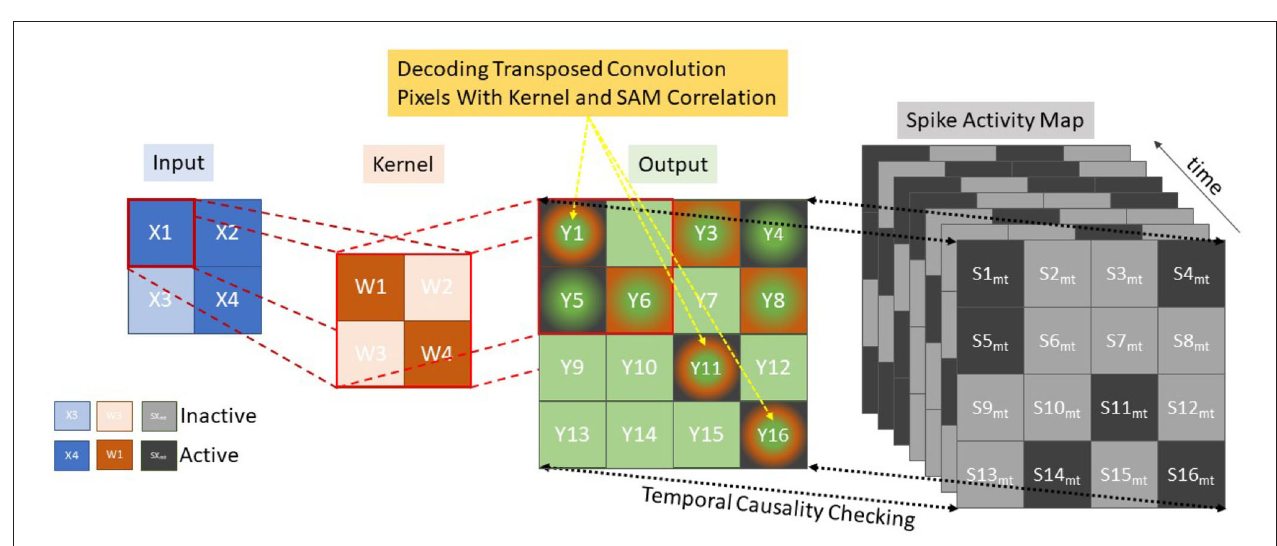
FIGURE 3 | Decoding using transposed convolutions with spike activity mapping, resulting in active pixel saliency